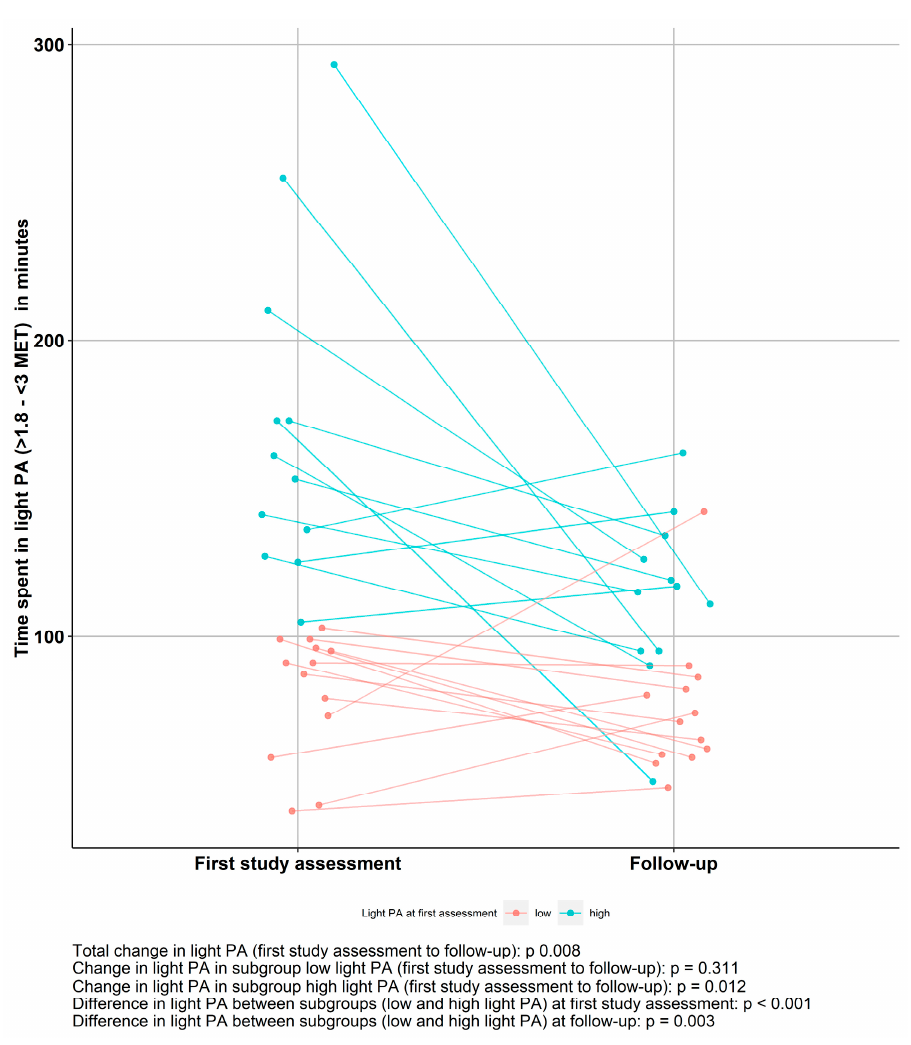
Figure 1. Light physical activity (PA) patterns in anorexia nervosa (AN) patients over time grouped by median split based on light PA at first study assessment (low light PA, n = 13; high light PA, n = 12).